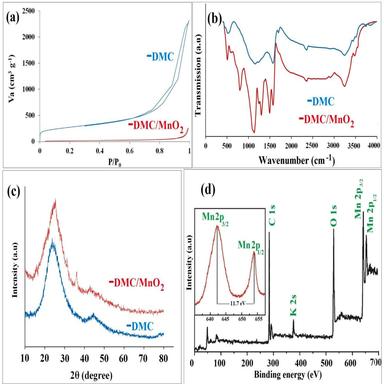
(a) N2 adsorption/desorption isotherm; (b) FT-IR spectra; (c) XRD pattern of DMC and DMC/MnO2 and (d) XPS spectra of DMC/MnO2.